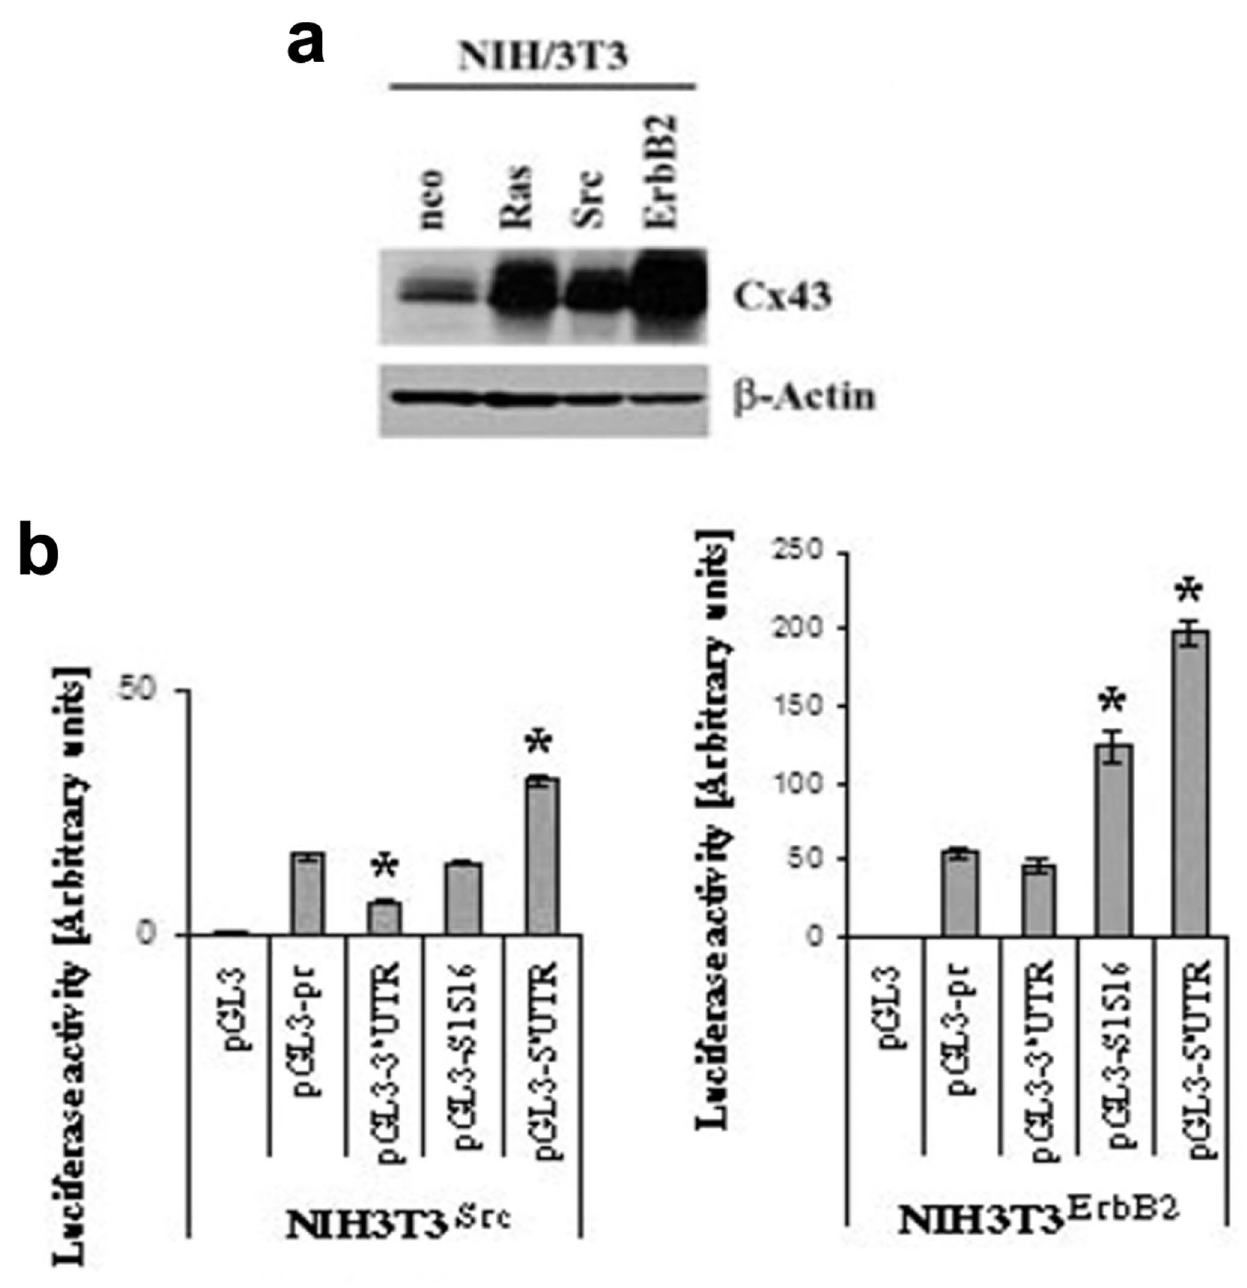
Figure 5. 3 9 UTR and 5 9 UTR-driven effects in Src and ErbB2-transformed cells. a) Western blot of the Cx43 expression in protein extracts from NIH3T3 Neo , NIH3T3 Ras , NIH3T3 Src and NIH3T3 ErbB2 cells. An antibody to b -Actin is used as a control for equal loading. b) Luciferase assay using the NIH3T3 Neo , NIH3T3 Src and NIH3T3 ErbB2 cells transfected with various Cx43 mRNA 3 9 and 5 9 UTR constructs. The experiments were performed at least three times in quadruplicates (* p , 0.05). doi:10.1371/journal.pone.0058500.g005 (Figure 7). The fact that the cellular model of Ras-transformed NIH3T3 shows a silencing of S1516 but still shows higher levels of Cx43 might be due to the absence of additional oncogenic events which would silence the 5 9 UTR positive regulation, while Ras is responsible for silencing the S1516 regulatory element.